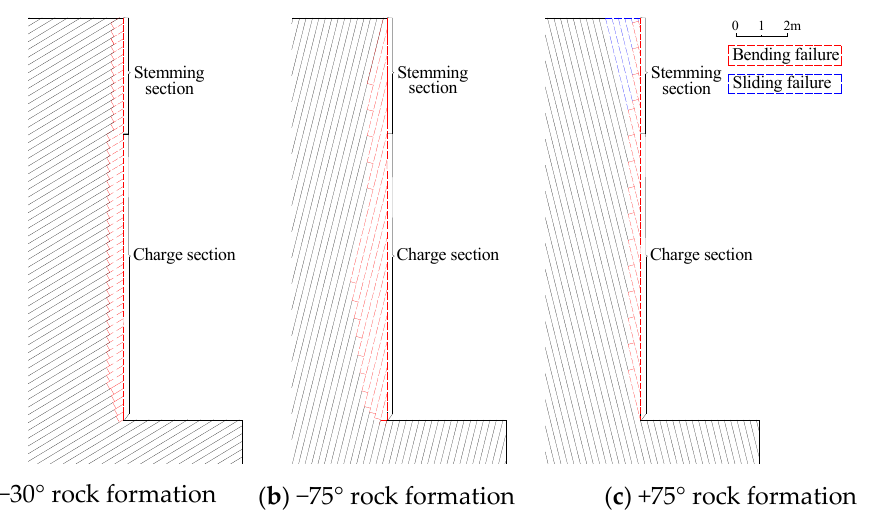
Figure 6. Diagram of the over-break sequence of the free surface in layered rock with different dip angles